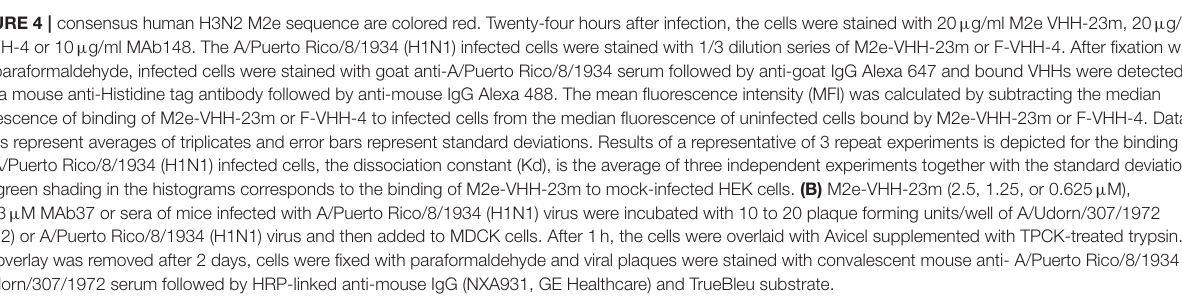
FIGURE 4 | consensus human H3N2 M2e sequence are colored red. Twenty-four hours after infection, the cells were stained with 20 µ g/ml M2e VHH-23m, 20 µ g/ml F-VHH-4 or 10 µ g/ml MAb148. The A/Puerto Rico/8/1934 (H1N1) infected cells were stained with 1/3 dilution series of M2e-VHH-23m or F-VHH-4. After fixation with 2% paraformaldehyde, infected cells were stained with goat anti-A/Puerto Rico/8/1934 serum followed by anti-goat IgG Alexa 647 and bound VHHs were detected with a mouse anti-Histidine tag antibody followed by anti-mouse IgG Alexa 488. The mean fluorescence intensity (MFI) was calculated by subtracting the median fluorescence of binding of M2e-VHH-23m or F-VHH-4 to infected cells from the median fluorescence of uninfected cells bound by M2e-VHH-23m or F-VHH-4. Data points represent averages of triplicates and error bars represent standard deviations. Results of a representative of 3 repeat experiments is depicted for the binding to the A/Puerto Rico/8/1934 (H1N1) infected cells, the dissociation constant (Kd), is the average of three independent experiments together with the standard deviation. The green shading in the histograms corresponds to the binding of M2e-VHH-23m to mock-infected HEK cells. (B) M2e-VHH-23m (2.5, 1.25, or 0.625 µ M), 0.333 µ M MAb37 or sera of mice infected with A/Puerto Rico/8/1934 (H1N1) virus were incubated with 10 to 20 plaque forming units/well of A/Udorn/307/1972 (H3N2) or A/Puerto Rico/8/1934 (H1N1) virus and then added to MDCK cells. After 1h, the cells were overlaid with Avicel supplemented with TPCK-treated